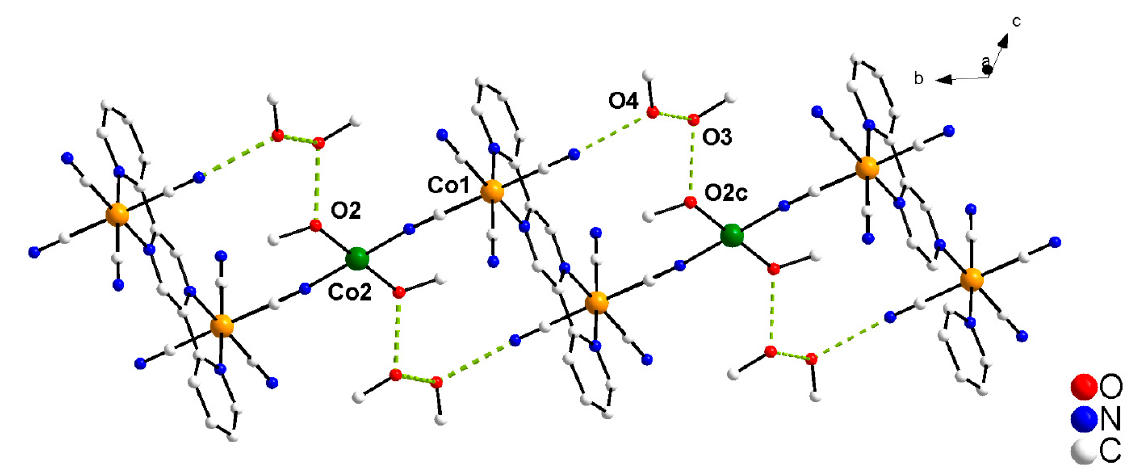
Figure 2. A view of the hydrogen bonds pattern (dashed lines) in 1 . The DMSO molecules were not represented for the sake of clarity (Symmetry code: (c) = x , –1 + y , z ). Table 2. Hydrogen bonds in 1 and 2 (compound 1/ compound 2 ).